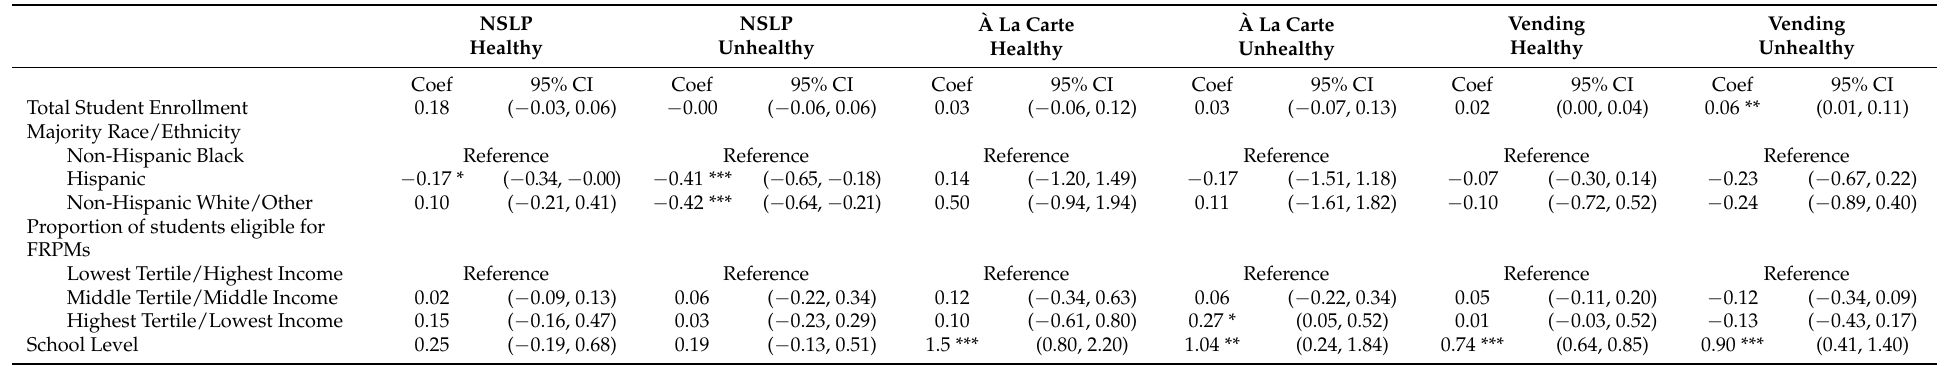
Table 2. Association between each index (NSLP healthy and unhealthy, à la carte healthy and unhealthy, vending healthy and unhealthy) and school-level factors (total student enrollment, majority race/ethnicity, proportion of students eligible for FRPMs, and school level) over the study period (2010-11 to